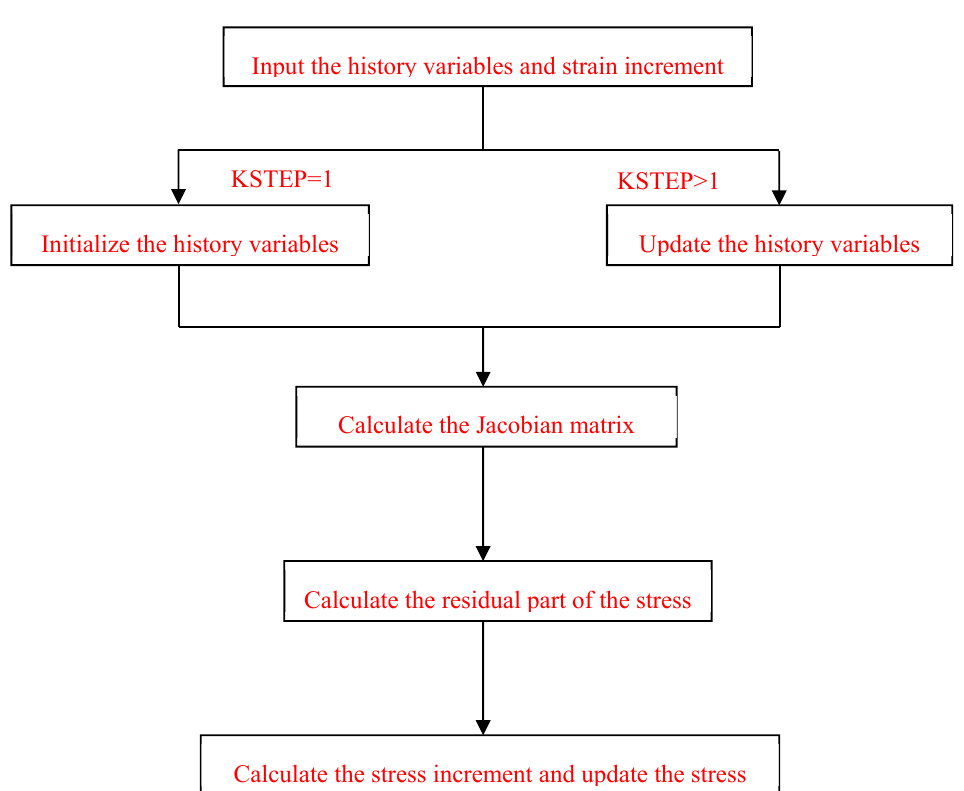
Figure 3. The flowchart for the three-dimensional numerical constitutive model derivation procedure.